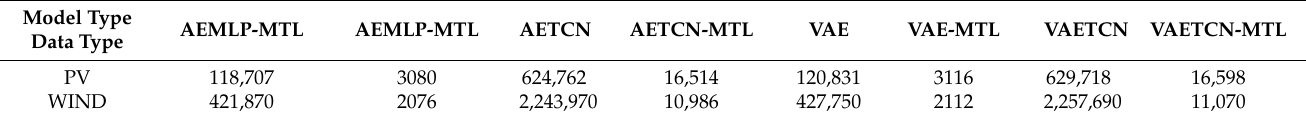
Table 3. The number of parameters for all autoencoder architectures for an example latent size of two. Other latent sizes solely differ slightly in the additional parameters required for the latent features. The number of parameters for the three wind and three PV datasets are summed for readability. The abbreviations here are the same as those in Table 2.